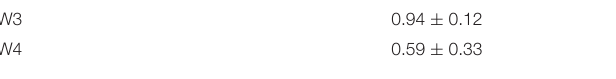
TABLE 4 | Phenotypic (above) and genetic (below the diagonal) correlations.